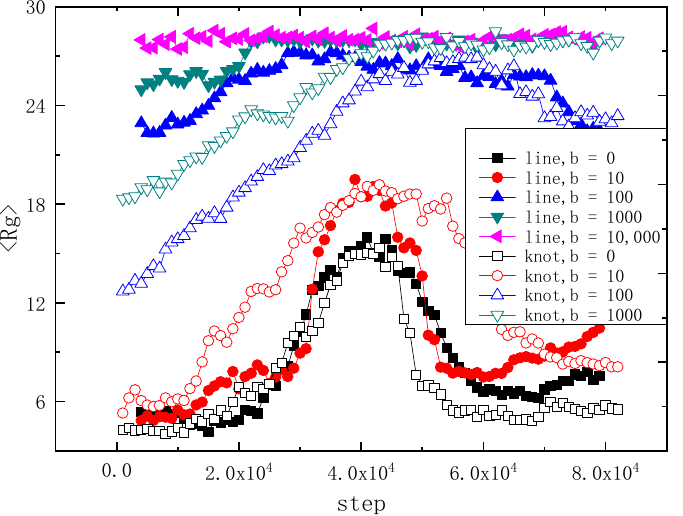
Figure 5. Average gyration radius <Rg> of linear chain and trefoil knot chain, with different bend parameter b, variate with the time steps. There are 100 monomers in each chain. The filled symbols indicate the linear chain, and the hollow symbols represent the 3 1 knot chain; the same shape and color online symbols represent the same rigidity.